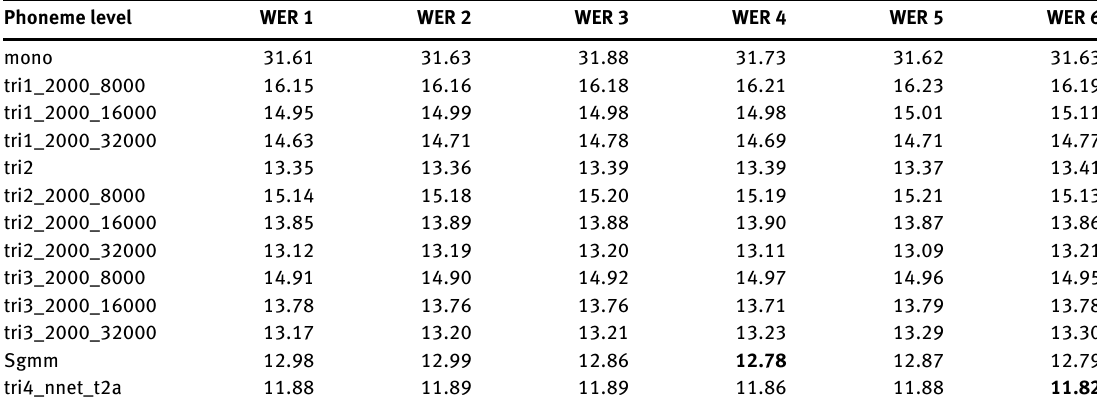
Table 18: The Description of WERs at Different Phoneme Levels for Overall Noisy Speech Data, Which Includes Districts, Mandis, and